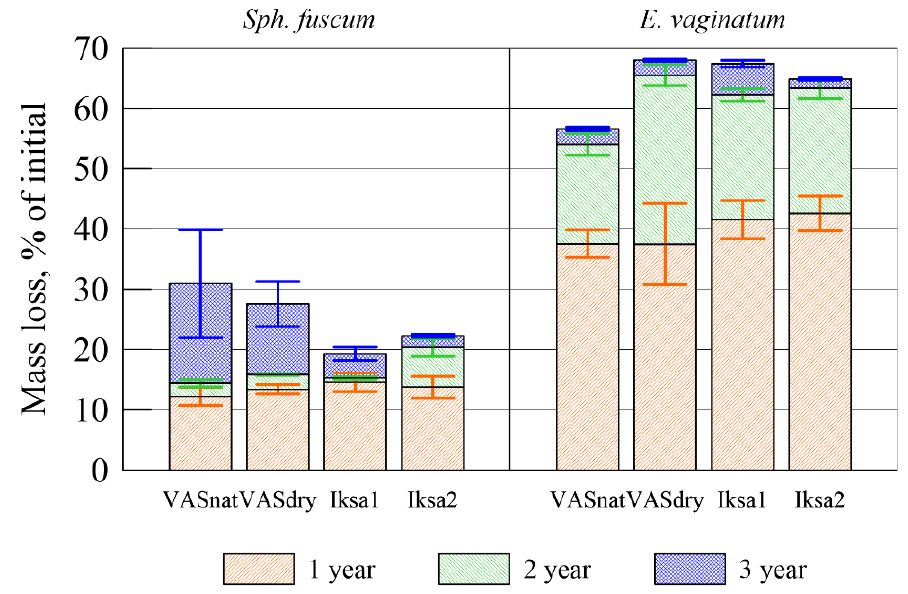
Figure 3. Dynamics of mass loss of Sph. fuscum and E. vaginatum at different observation points.